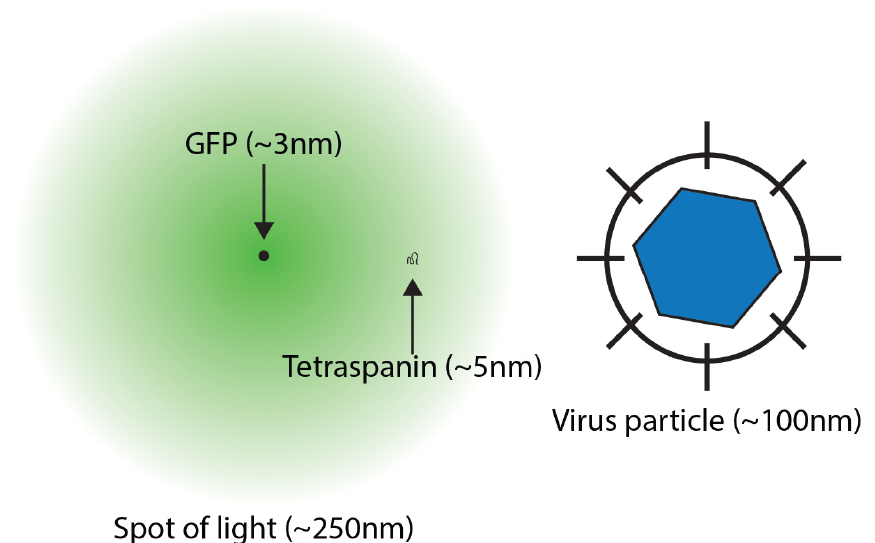
Figure 1. Molecular Scales and Microscopy. The cartoon illustrates the relative sizes of relevant nanoscale objects. Green fluorescent protein (GFP) has a roughly cylindrical structure measuring ~2 × 5 nm, however, when viewed under a microscope the light emitted from a single GFP molecule diffracts to appear as a spot of light measuring approximately 250 nm in diameter. The large extracellular loop of a tetraspanin extends for 3–5 nm, whereas virus particles typically range from 20–1000